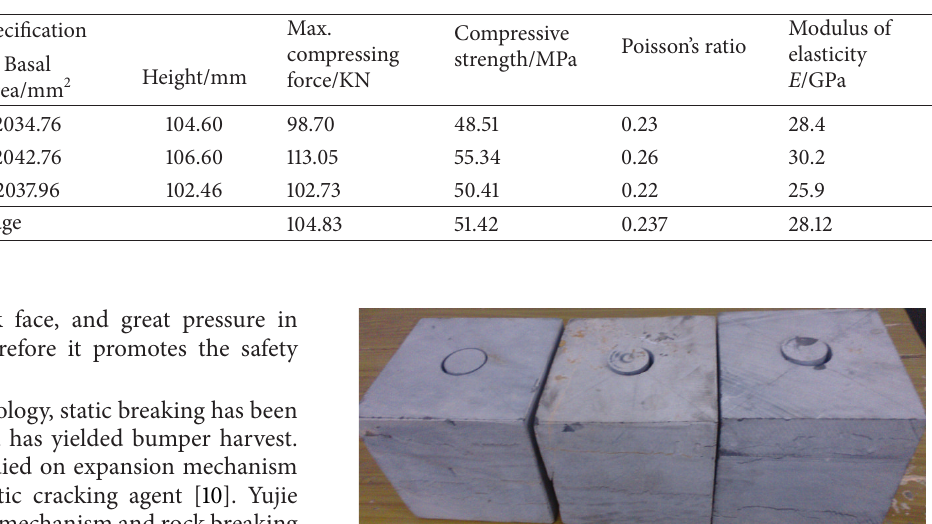
Table 1: The main mechanical parameters of limestone needed for the